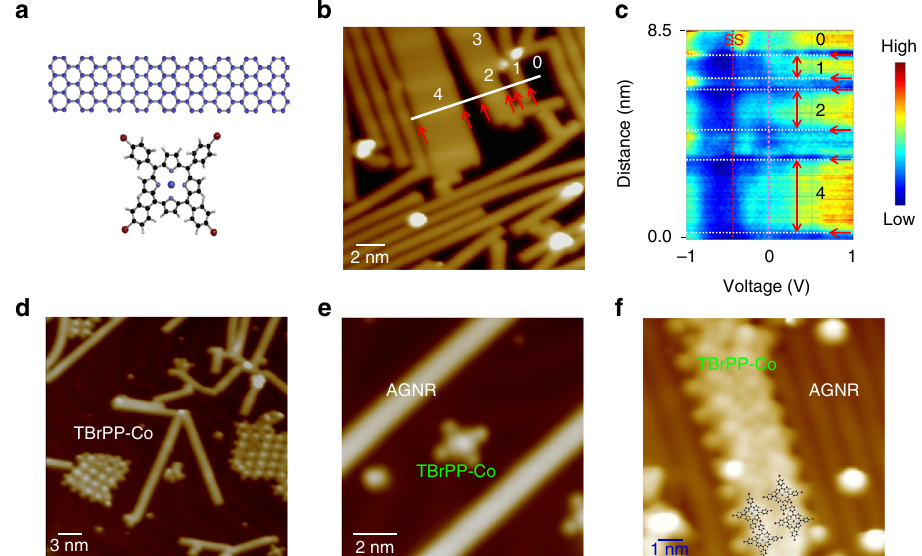
Fig. 1 TBrPP-Co/AGNR heterostructures. a Structure of 7-AGNR ( top ) and TBrPP-Co ( bottom ). b A scanning tunneling microscope (STM) image showing AGNRs with various widths on Au(111) (16.5 × 16.5 nm 2 , I t = 1 × 10 − 10 A, V t = 1 V). Here, 1, 2, 3 and 4 label 7, 14, 21 and 28-AGNR, respectively. c d I /d V spectroscopy scan as a function of distance measured along a white line in b . Regions 1, 2 and 4 label corresponding AGNRs in b and 0 is Au(111). The arrows indicate the edge of AGNRs, while the red dot line marks the Shockley surface state (SS) on-set of Au(111). (Tip set-point: I 0 = 1.0 × 10 − 10 A, V 0 = 1.0 V). d An STM image shows TBrPP-Co clusters grow in between AGNRs on Au(111) (31 × 31 nm 2 , I t = 3 × 10 − 11 A, V t = − 0.1 V). e STM image of a single TBrPP-Co adsorbs on Au(111) between two AGNRs (11 × 11 nm 2 , I t = 5 × 10 − 11 A, V t = − 0.2 V). f STM image of TBrPP-Co molecular chains formed on top